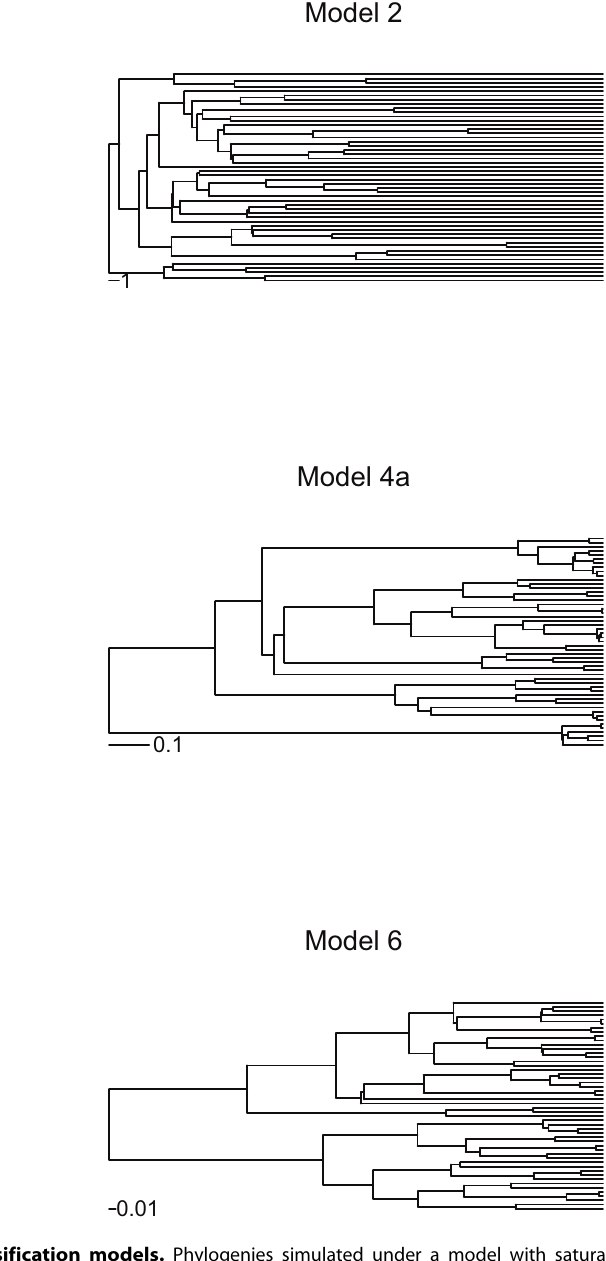
Figure 2. Example phylogenies resulting from different diversification models. Phylogenies simulated under a model with saturated diversity and a constant turnover rate (Model 1) have short terminal branches compared to phylogenies simulated under the pure-birth process (Yule model; Model 5). With saturated diversity but decaying turnover rates, terminal branches become longer (Model 2). Compared to the pure-birth process (Model 5), the presence of extinction pushes phylogenetic nodes towards the tips (Model 3), whereas a decay in speciation rate pushes them towards the root (Model 6). In the presence of both extinction and a decay in speciation rate (Model 4), however, these two effects counteract, producing a phylogeny that appears similar to the pure-birth model. All phylogenies were simulated with the same initial speciation rate (six speciation events per time unit). The extinction rate in Models 3 and 4a was identical (three speciation events per time unit). The exponential variation in speciation rate in Models 2, 4a, and 6 was identical (0.25 per time unit). Note the different time